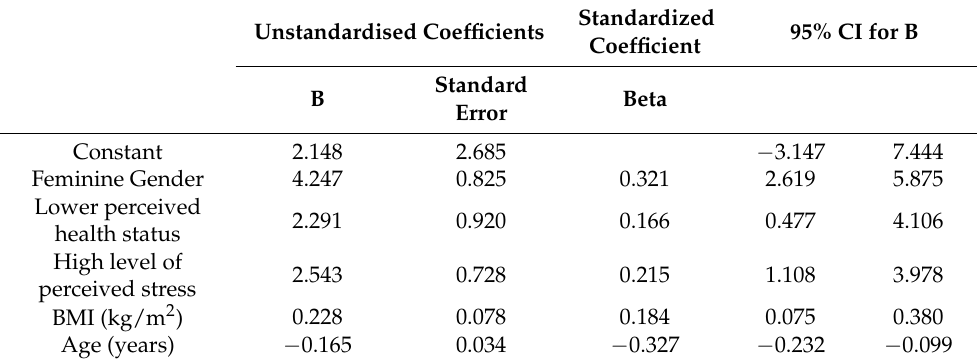
Table 5. Linear regression for predicting EE score ( n = 200).